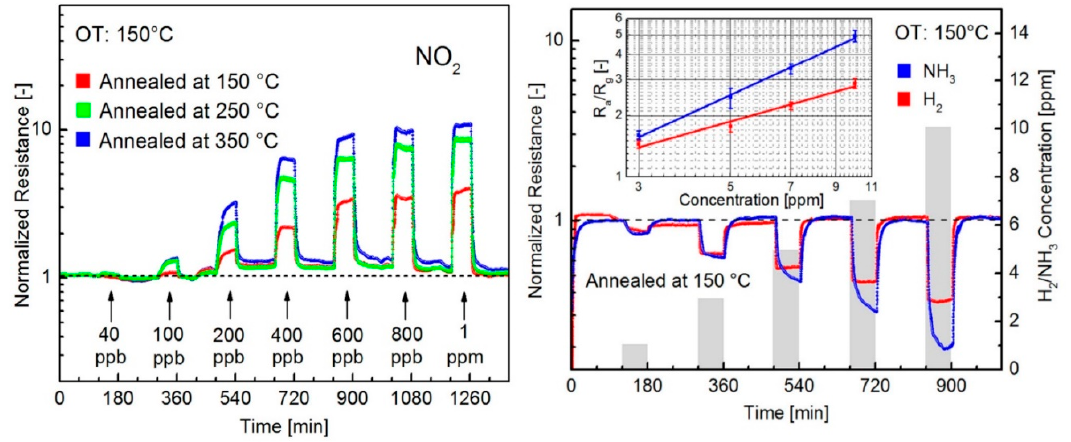
Figure 19. ( Left panel ) NO 2 sensing responses of the WS 2 sensors annealed at different temperatures; ( Right panel ) sensing responses to NH 3 and H 2 of the 150 °C annealed device. The inset reports the calibration curves for NH 3 (blue curve) and H 2 (red curve). (Adapted and reprinted from [193], with permission from Elsevier, Amsterdam, The Netherlands).